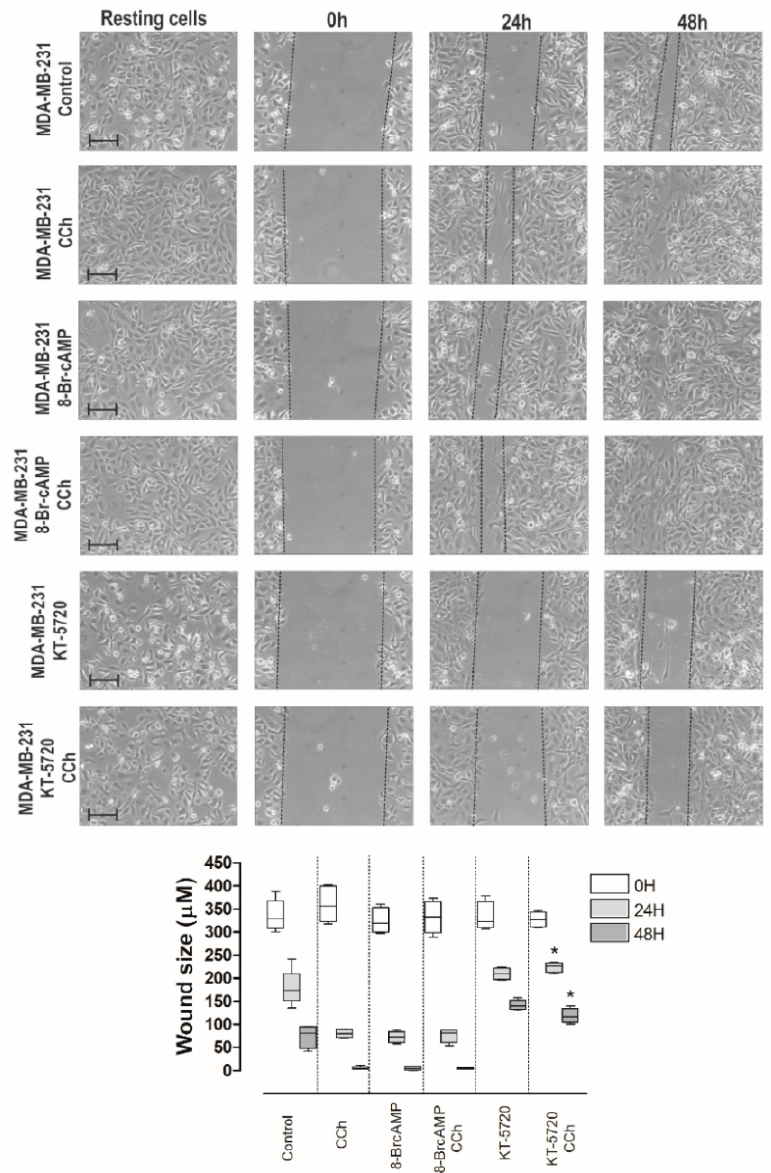
Figure 8. Role of the cAMP–PKA pathway in MDA-MB-231 cell migration. MDA-MB-231 cells were stimulated with 10 µM carbachol (CCh) or the vehicle in the absence or presence of 8-bromo-cAMP (8-Br-cAMP; 300 µM) or KT-5720 (1 µM), and subjected to a wound healing assay as described in Section 4. Images were acquired at 0, 24, and 48 h from the beginning of the assay. The dotted lines define the areas lacking cells. The bars represent 100 µm. The box plot represents the wound size, in micrometers, at the different conditions ( n = 6); * p < 0.05 compared to the corresponding time in CCh-treated cells.